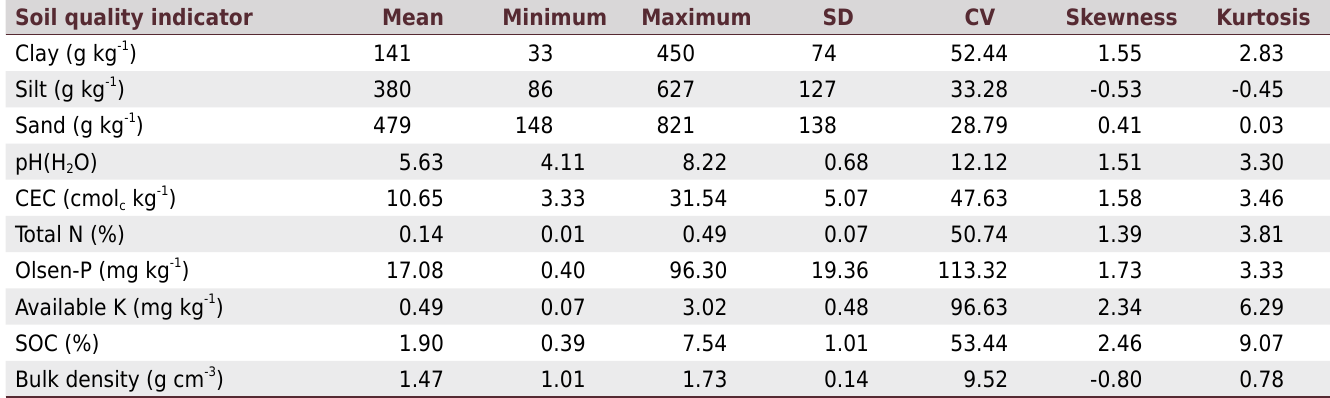
Table 1. Descriptive statistics of the whole dataset (n = 194; sampling layer: 0.00-0.30 m) Soil quality